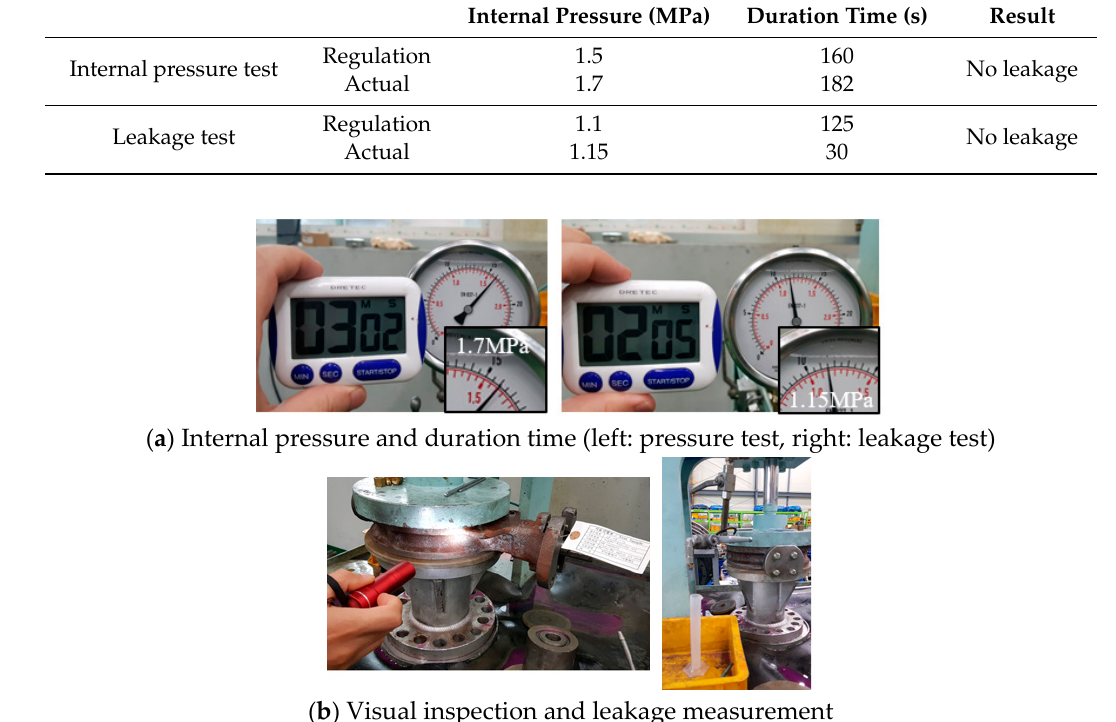
Figure 20. Conditions and results of the performance tests.